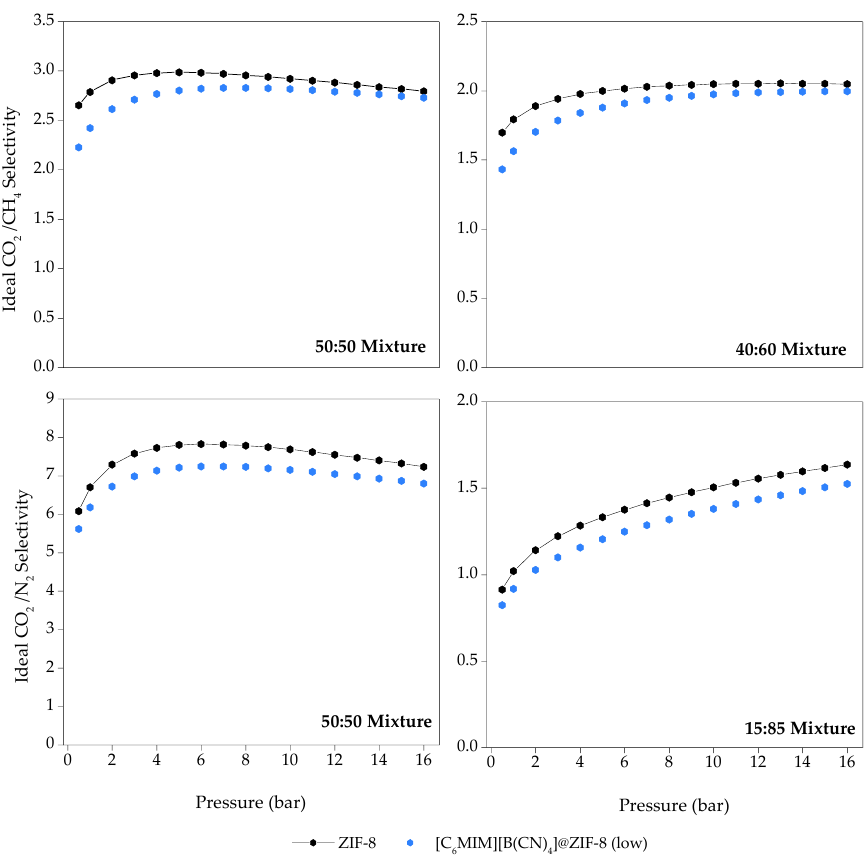
Figure 9. Ideal CO 2 /CH 4 and CO 2 /N 2 selectivities for the pristine ZIF-8 and [C 6 MIM][B(CN) 4 ]@ZIF- 8 (low) as a function of total pressure, determined from the Sips isotherm model fitting of the single- component adsorption/desorption isotherms, measured at 303 K and in the pressure range of 0.5 – 16 bar.